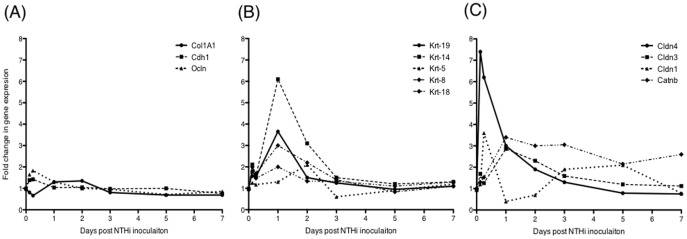
Changes in gene expression of epithelial cell genes in the responding mucosal epithelium after NTHi infection.Panel A, Unchanged. The expression of some epithelial genes like E-cadherin (Cdh1), occludin (Ocln) and collagen-1A1 (Col1A1) were minimally affected by the inflammatory response after NTHi infection. Panel B, Epithelial cytokeratins: The expression of several cytokeratins in the ME increased in correlation to the inflammatory response and mucosal thickening at 24 to 48 hrs. cytokeratin 19 (Krt-19), cytokeratin 14 (Krt-14), cytokeratin 18 (Krt-18), cytokeratin-5 (Krt-5) and cytokeratin 8 (Krt-8). Panel C, Tight junction genes: Expression of the claudins family that have been shown to specifically target tight junctions. Claudin-4 (Cldn-4) and claudin-1 (Cladn-1) gene expression was up-regulated early in response to NTHi infection. In contrast, changes in claudin-3 (Cladn-3) and β-catenin gene expression were moderate and up-regulated later on in the course of OM.